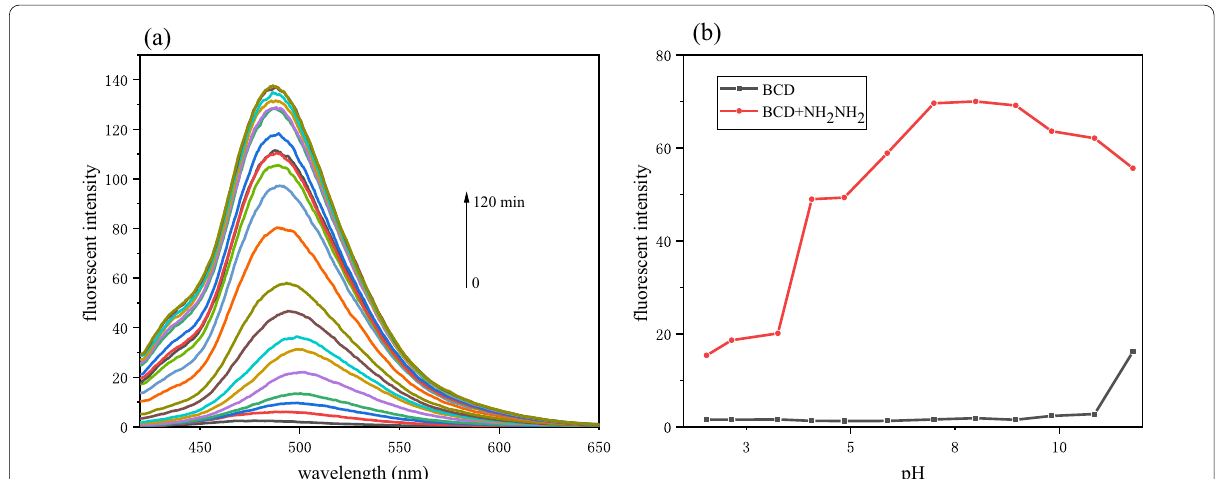
Fig. 2 a Time-dependent fluorescence spectral changes of probe BCD (60 μM) after treatment with N 2 H 4 (100 μM) in the DMF-Hepes buffer (7/3, v/v, pH 7.4), λex 407 nm; b Fluorescent intensity at 458 nm of BCD (60 μM) at various pH values in DMF-Hepes buffer (7/3, v/v, pH = = in the absence and presence of N